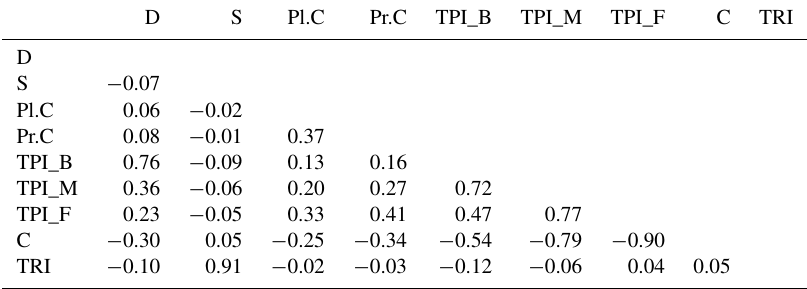
Table A1. Spearman’s correlation coefficient for each pair of predictor variables.